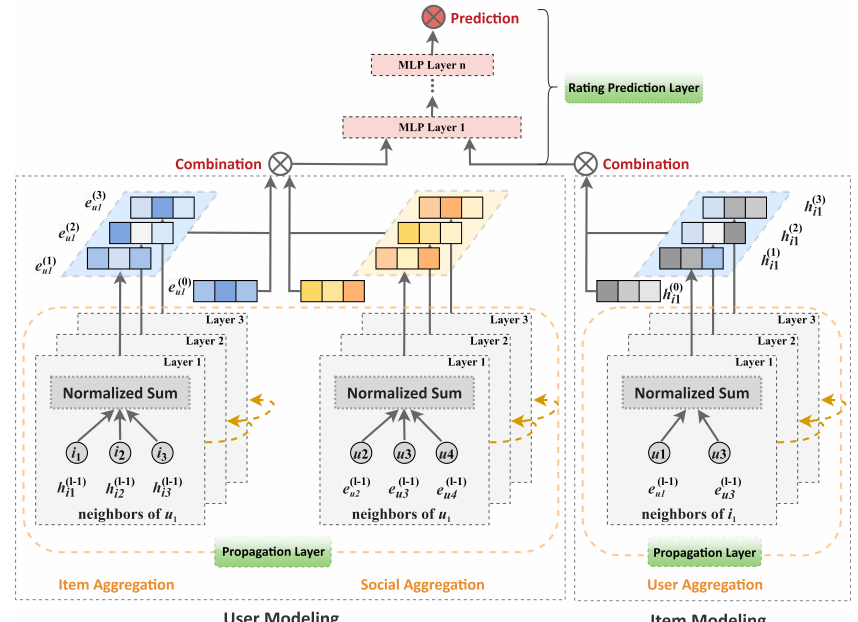
Figure 1. The framework of the proposed recommendation